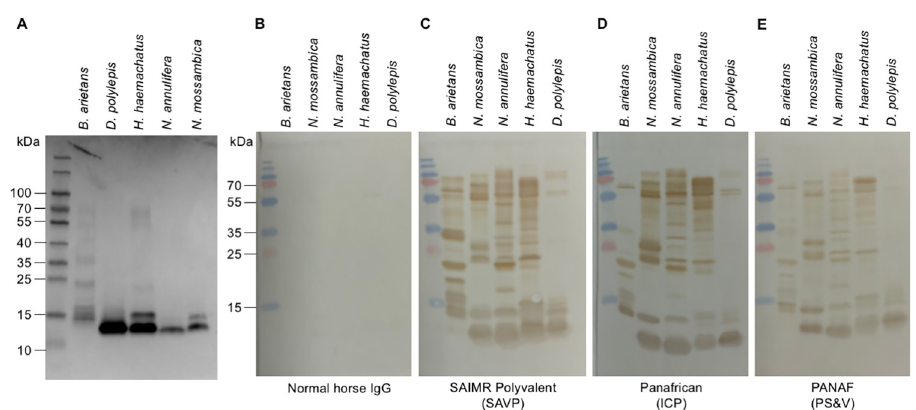
Fig 3. Protein profiles of the venom protein components of five Eswatini snake venoms. A: Venom proteins separated by SDS-PAGE under reducing conditions and stained with Coomassie blue to show all proteinaceous components. B: Immunoblot using normal horse IgG used as primary antibody negative control. C: Immunoblot using SAIMR Polyvalent as primary antibody. D: Immunoblot using Panafrican (ICP) antivenom as primary antibody. E: Immunoblot using PANAF (PS&V) antivenom as primary